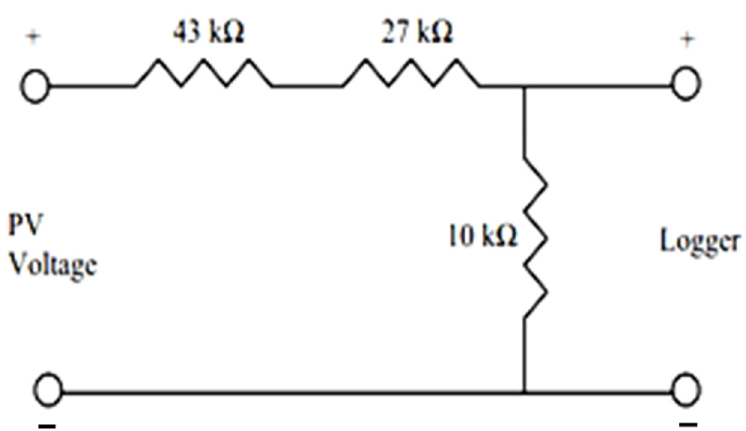
Figure 8. Set-up of signal conditioning using voltage divider approach